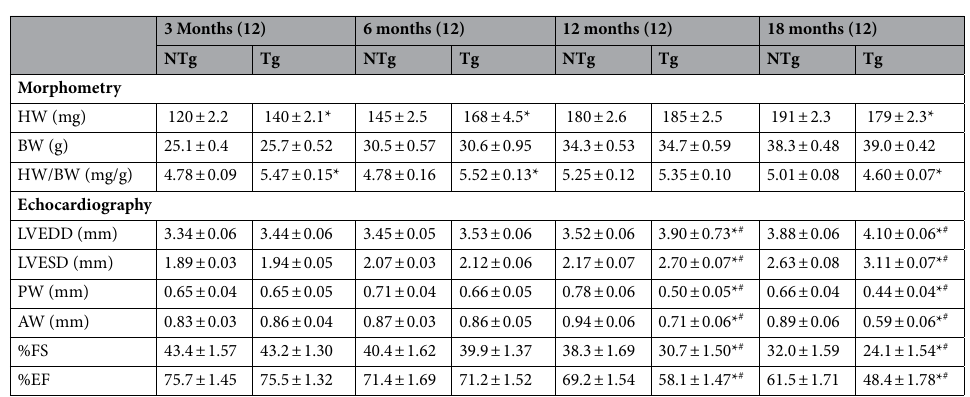
Figure 2. Cardiomyocyte expression of miRNA-7 leads to age-based cardiac dilation ( a ), M-mode echocardiography performed on NTg and Tg mice at 3, 6, 12 and 18 months (n = 12). ( b ), Cardiac functional parameters measured from echocardiography on NTg and Tg mice; Left panel: LVEDD (left ventricular end- diastolic dimension); Middle panel LVESD (left ventricular end-systolic dimension); Right panel: % fractional shortening (%FS) as measure of cardiac function. * p < 0.01 vs. 3 month NTg and Tg; # p < 0.05 vs. 3 month NTg and Tg. ( c ) Immunoblotting for ERBB2 in the total cardiac lysates from NTg and Tg mice. Immunoblotting for GAPDH was performed for loading control (n = 8). Summary data represented in the bar graph (right panel). * p < 0.001 vs. NTg. ( d ), Immunoblotting for ERBB2 and EGFR in isolated adult cardiomyocytes from NTg and Tg mice. Immunoblotting for GAPDH was performed as loading control (n = 4–5). Summary data represented in the bar graph (right panel). * p < 0.0005 vs. NTg.